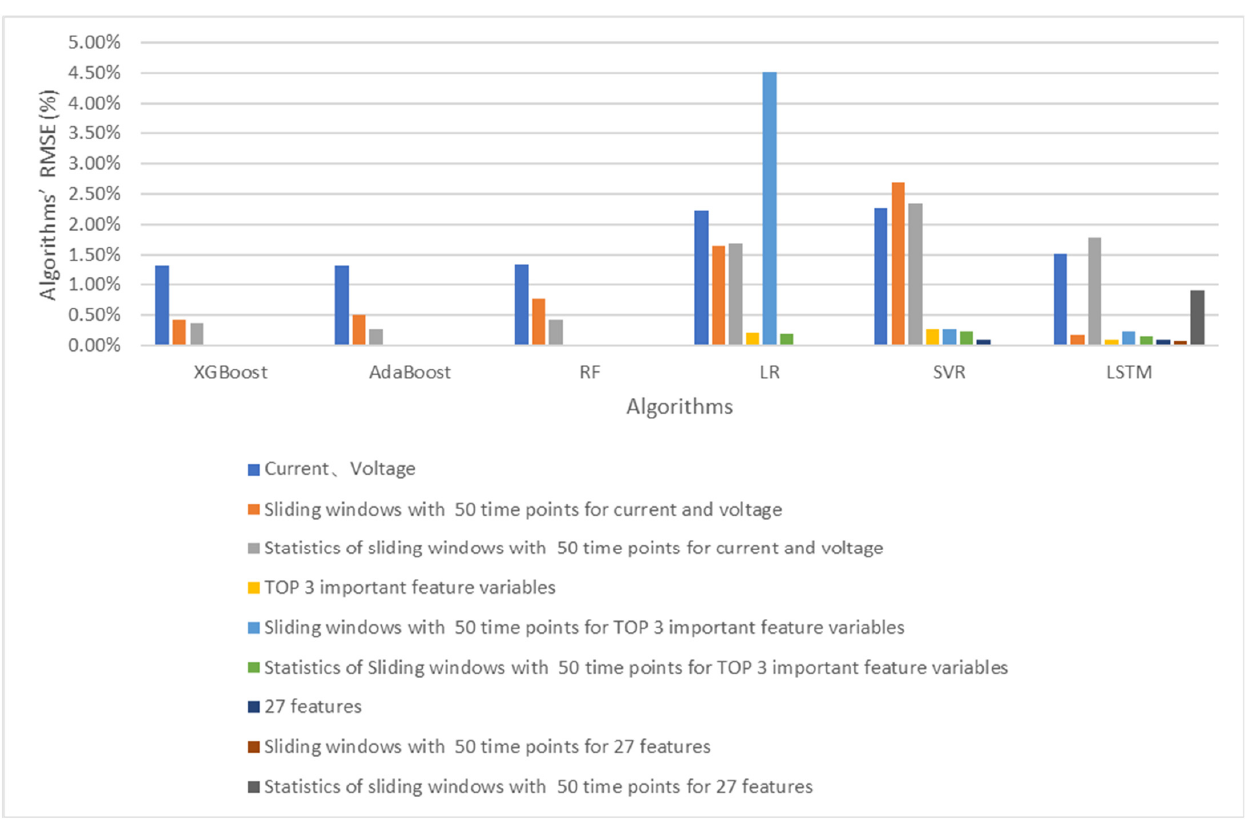
Figure 3. Comparison of the RMSE of algorithms when selecting different input variables (all). The MAE cluster histograms of each algorithm when selecting different input variables are shown in Figures 5 and